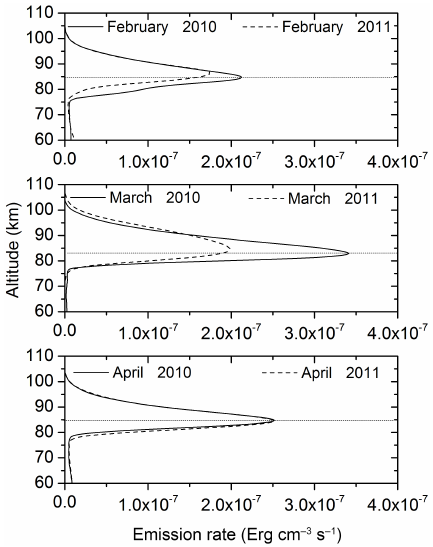
Figure 4. The monthly (February, March, and April) mean OH emission rate profiles from SABER for the years 2010 (solid lines) and 2011 (dashed